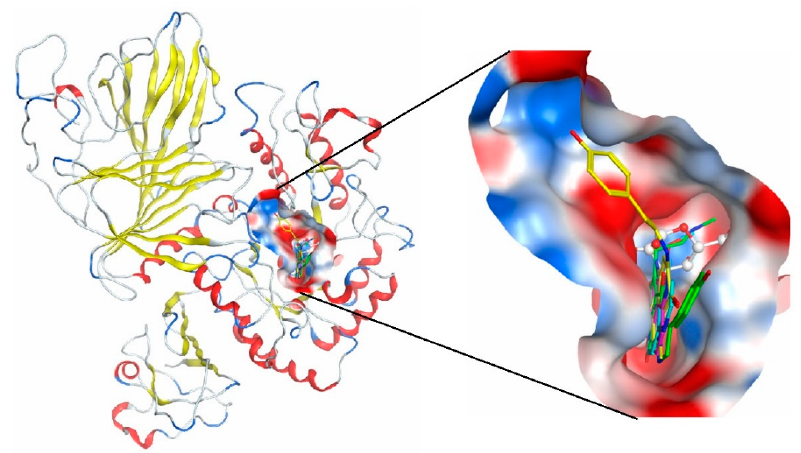
Figure 4. Superpositions of alkaloids 2 , 3 , 8, 9, and D-galactose in the active site of α -D-galactosidase. Ligands are shown as sticks. Isoaaptamine ( 2 ) is shown in pink; 9-demethylaaptamine ( 3 ) is shown in cyan; makaluvamine G ( 8 ) is shown in yellow; zyzzyanone A (9) is shown in green; D-galactose is shown in white. The molecular surface of the catalytic domain binding site is shown in red (neg- ative), blue (positive), and gray (neutral) classes.